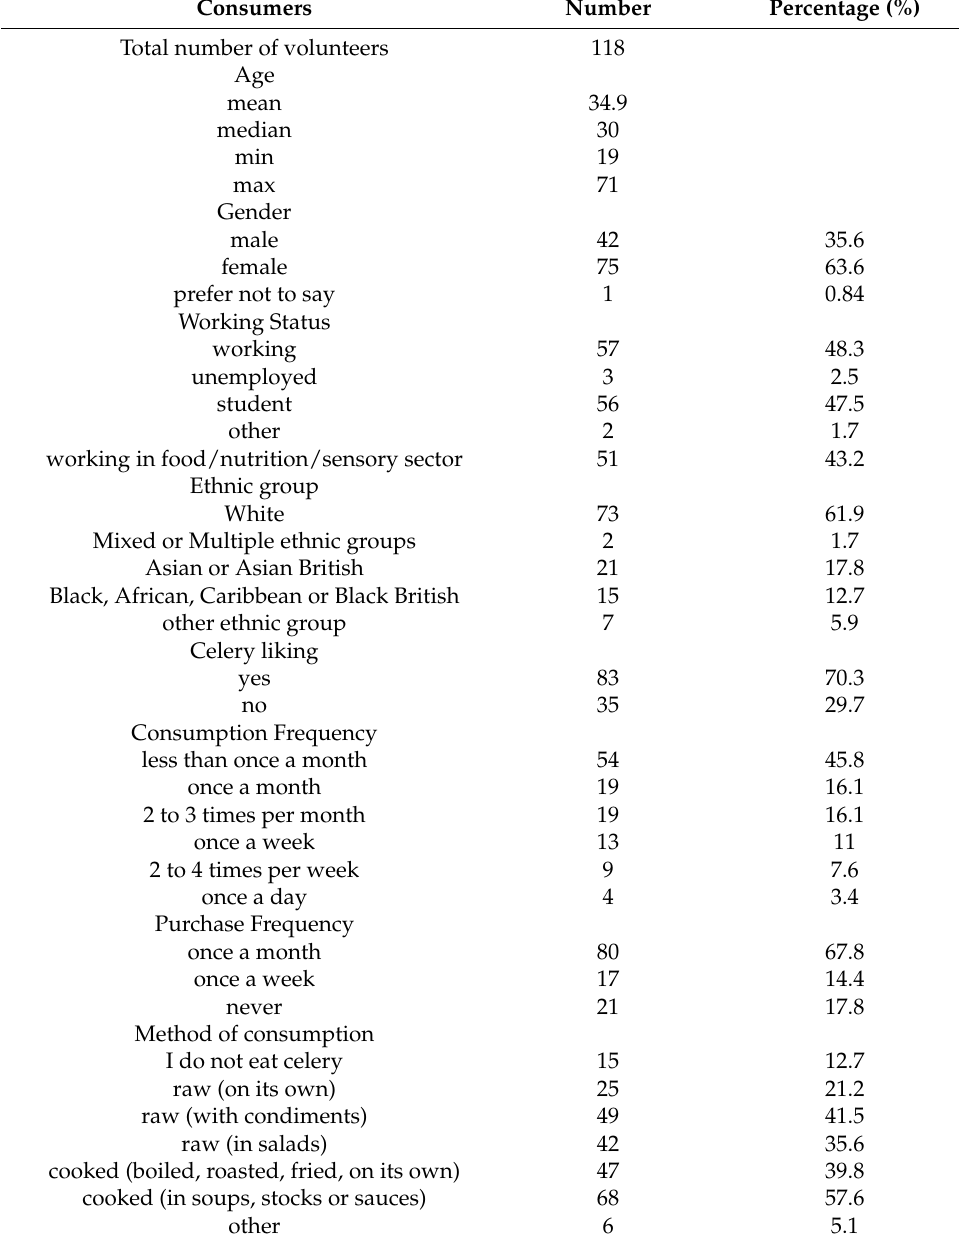
Table 3. Consumer demographics and characteristics of the consumer